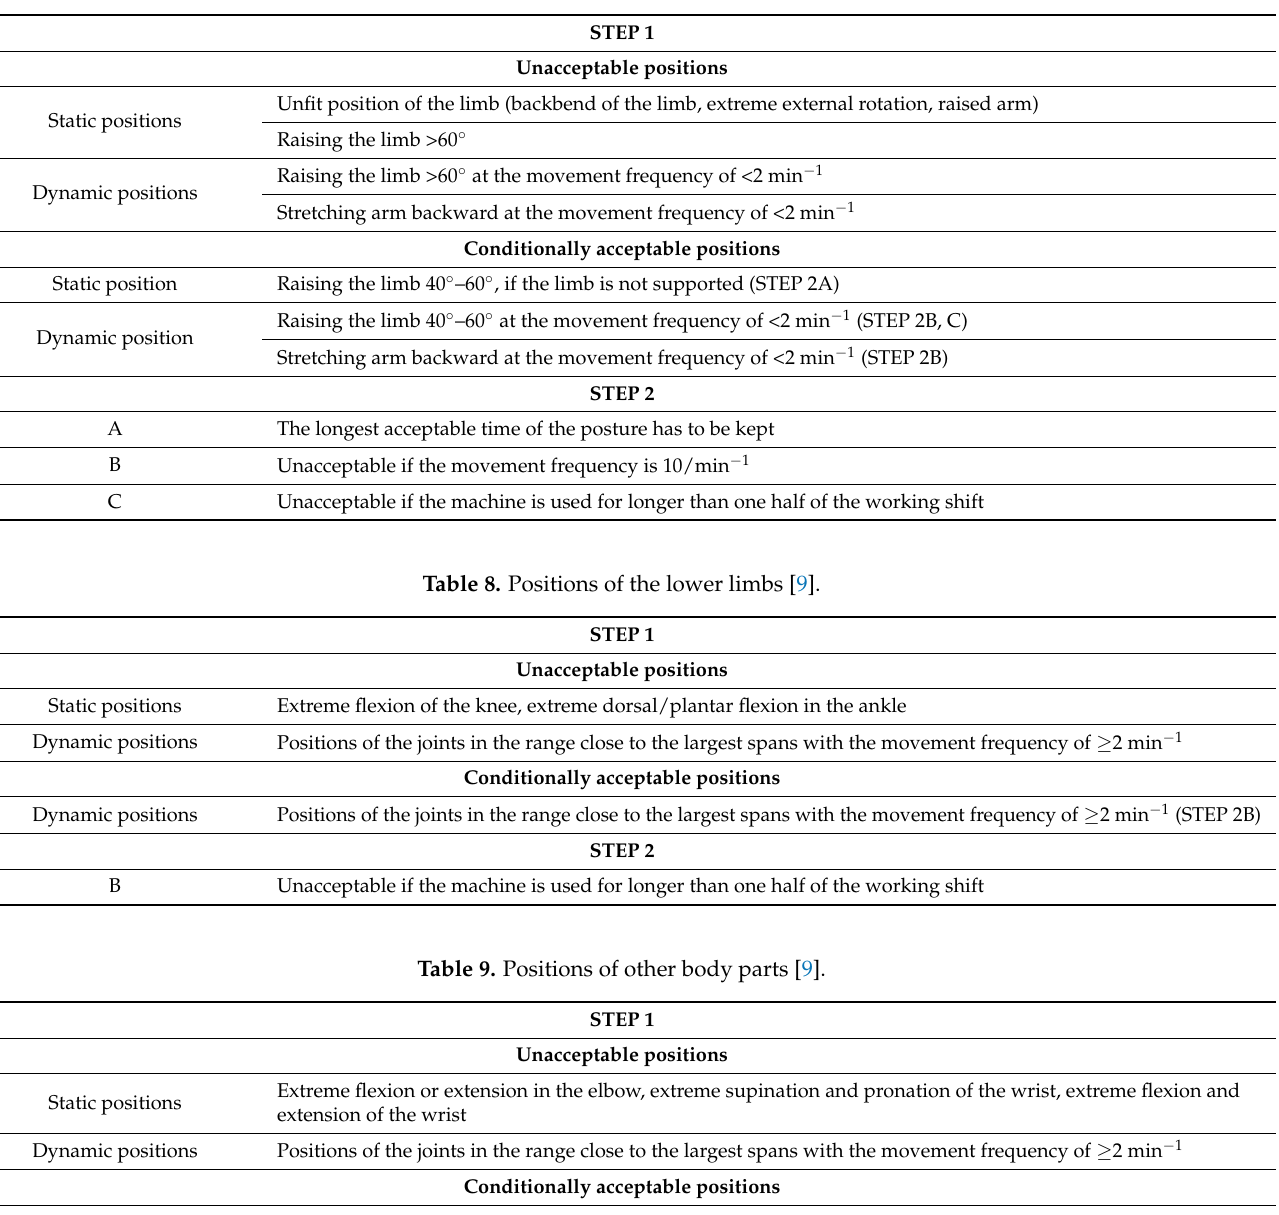
Table 7. Positions of the upper limbs [9].